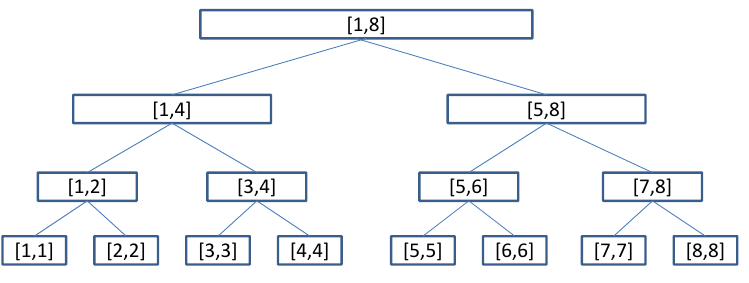
Figure 2. Interesting intervals for I = [1 , 8]